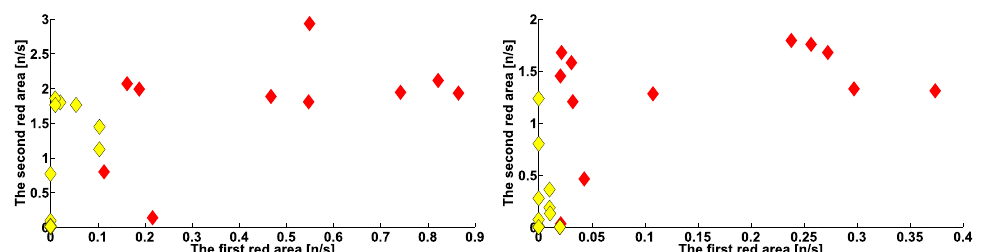
Figure 14. Scatter plot of the number of cross-wave trains per second in arms with hyperkinetic movements in PD and ET patients. Red diamonds are PD patients. Yellow diamonds are ET patients. ( Left ), the left arms in frequency ranges of 4–6 Hz (abscissa axis) and 8–18 Hz (ordinate axis). ( Right ), the right arms in frequency ranges of 2.5–6 Hz (abscissa axis) and 8–12 Hz (ordinate axis). Frequency ranges correspond to the rows in Tables 1 and 2. On the coordinate axes, the symbols of the corresponding rows in the tables are indicated. They consist of the color of the plot area under consideration on the corresponding AUC diagram and the ordinal number of this area in the corresponding table.